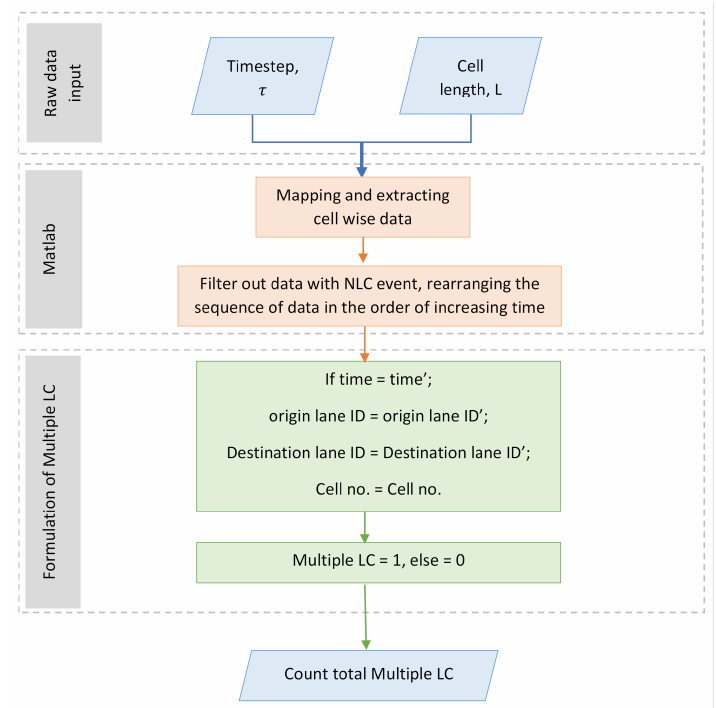
Figure 2. Framework for the selection of the base